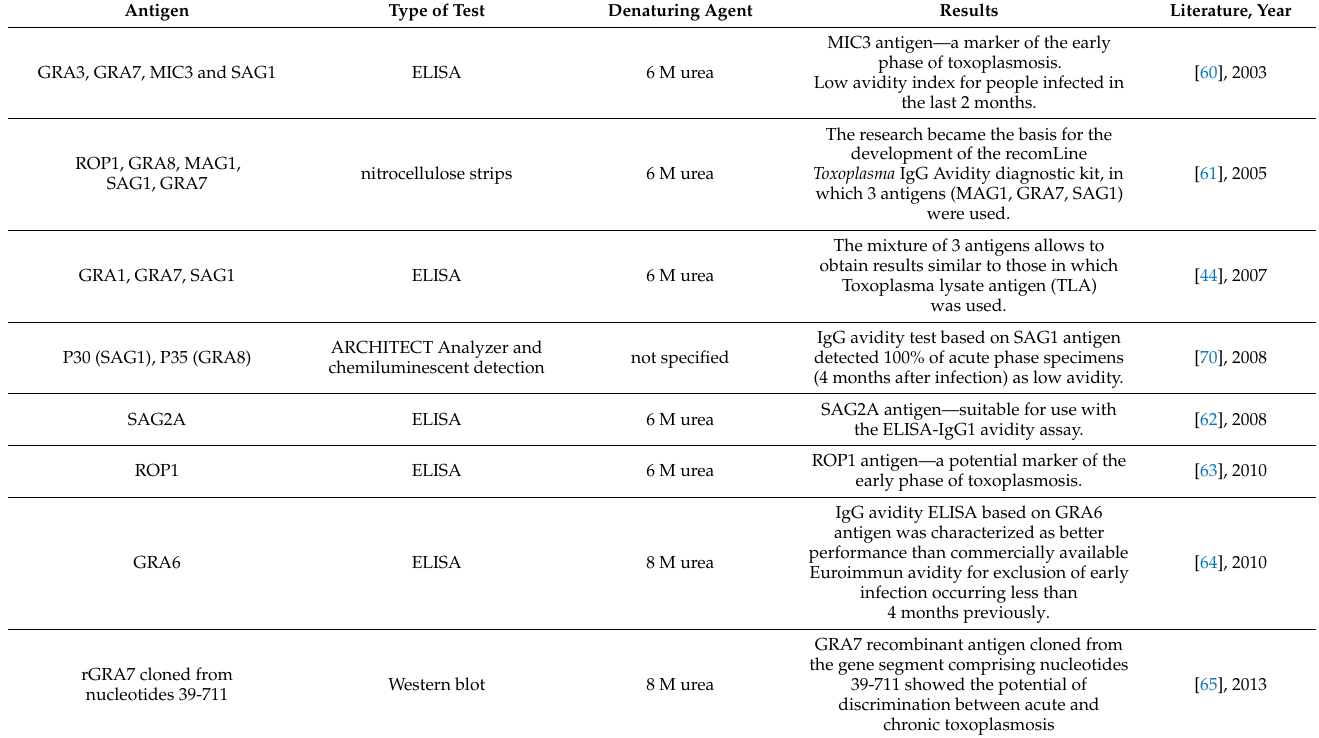
Table 1. Recombinant T. gondii antigens tested in the IgG avidity tests.